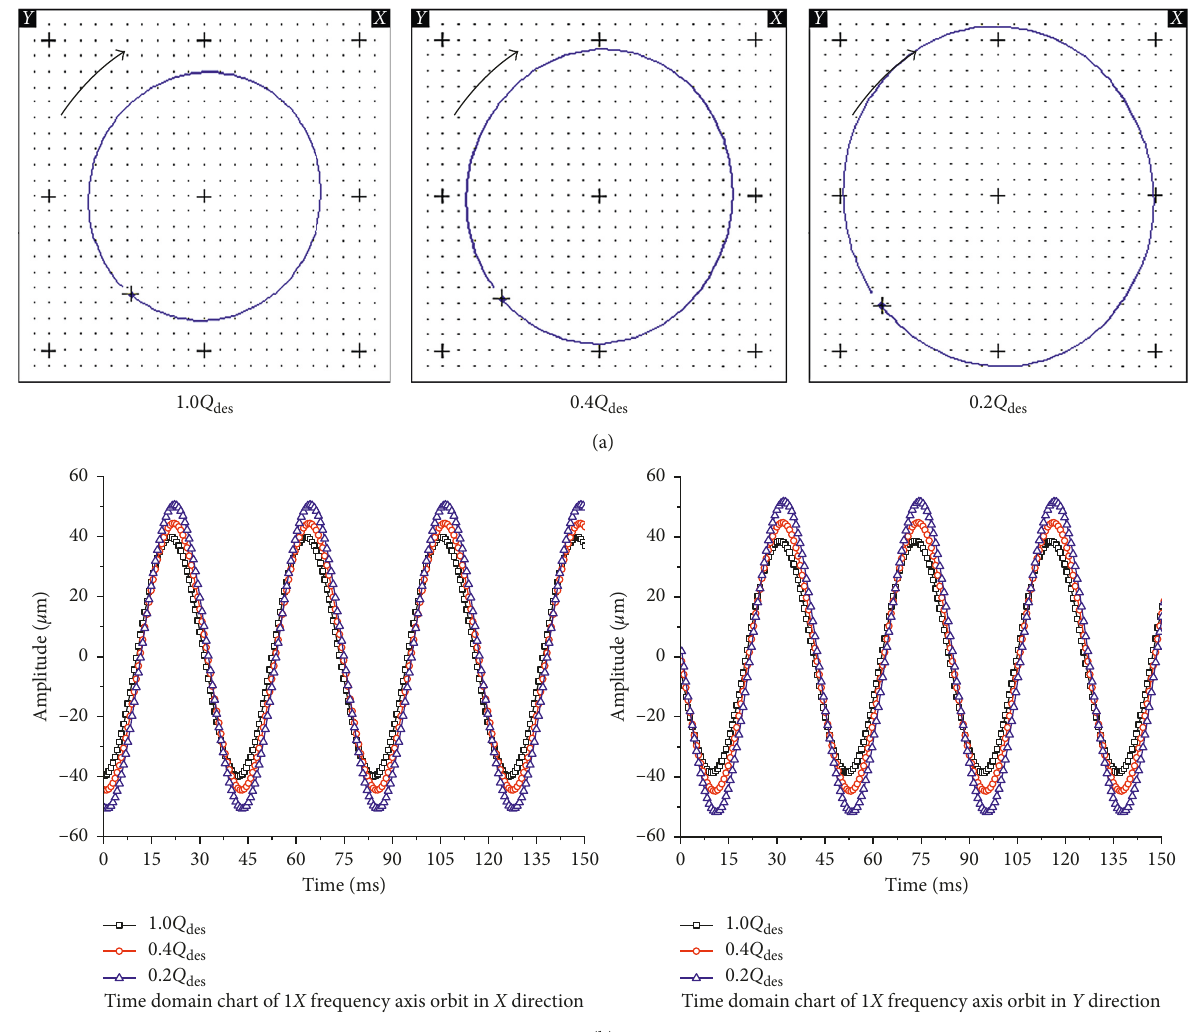
Figure 10: Axis orbit and time-domain diagram of 1 X frequency axis orbit. (a) Axis orbit diagram of 1 X frequency. (b) Time-domain diagram of 1 X frequency axis